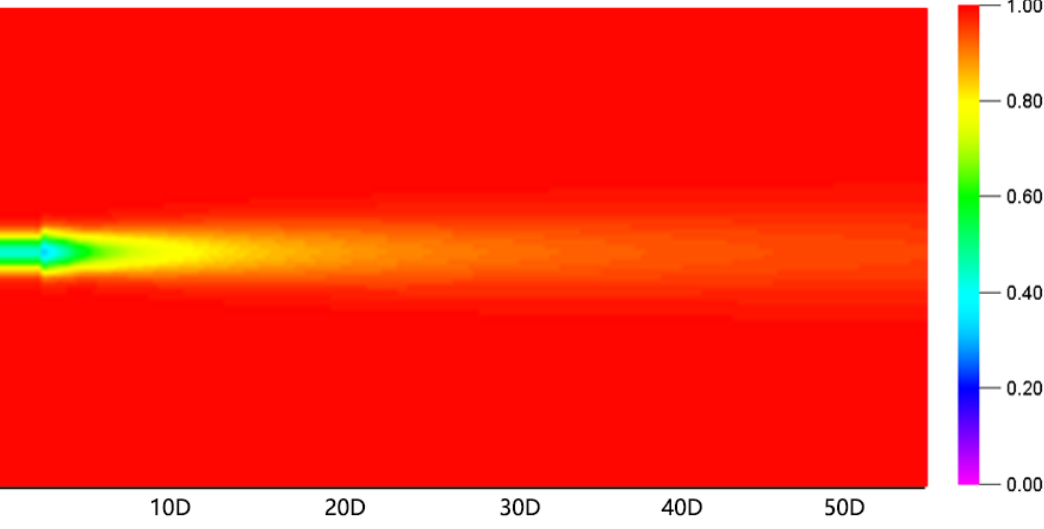
Figure 7. Single wake wind speed by ASM-EV wake model.